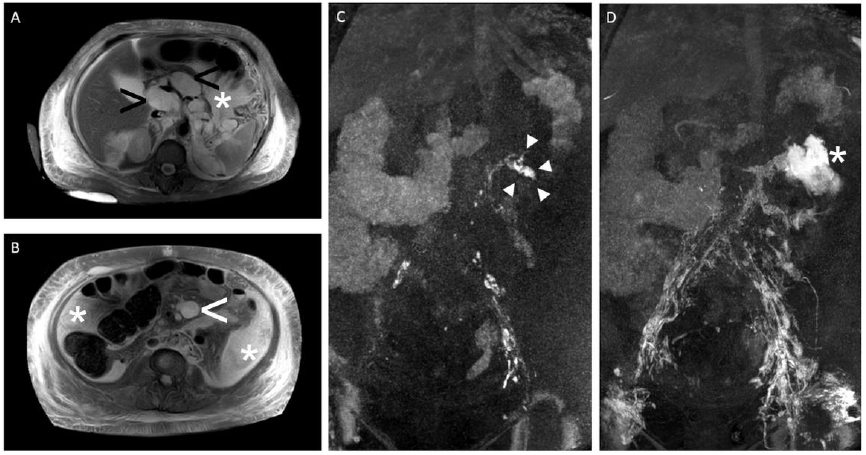
Figure 7. “Intranodal MR lymphangiography“— A 59-year-old woman with massive refractory chylaskos (>5000 mL per day) after retroperitoneal lymphadenectomy. Note: ( A , B ) T2-weighted, fluid-sensitive MRI (axial plane) showing ascites (white arrowhead), massive subcutaneous lymphedema (white asterisk), and multiple cystic/necrotic retroperitoneal and mesenteric lymph node metastases (black arrowhead); ( C , D ) dynamic contrast material (gadolinium)-enhanced “intranodal MR lymphangiography” (coronal maximum-intensity projection) showing the fistula point with pathologic contrast material extravasation from retroperitoneal lymph ducts on the left during con- trast material’s injection (white arrowhead) ( C ) and massive contrast material extravasation into the ascites after contrast material’s injection (white asterisk) ( D